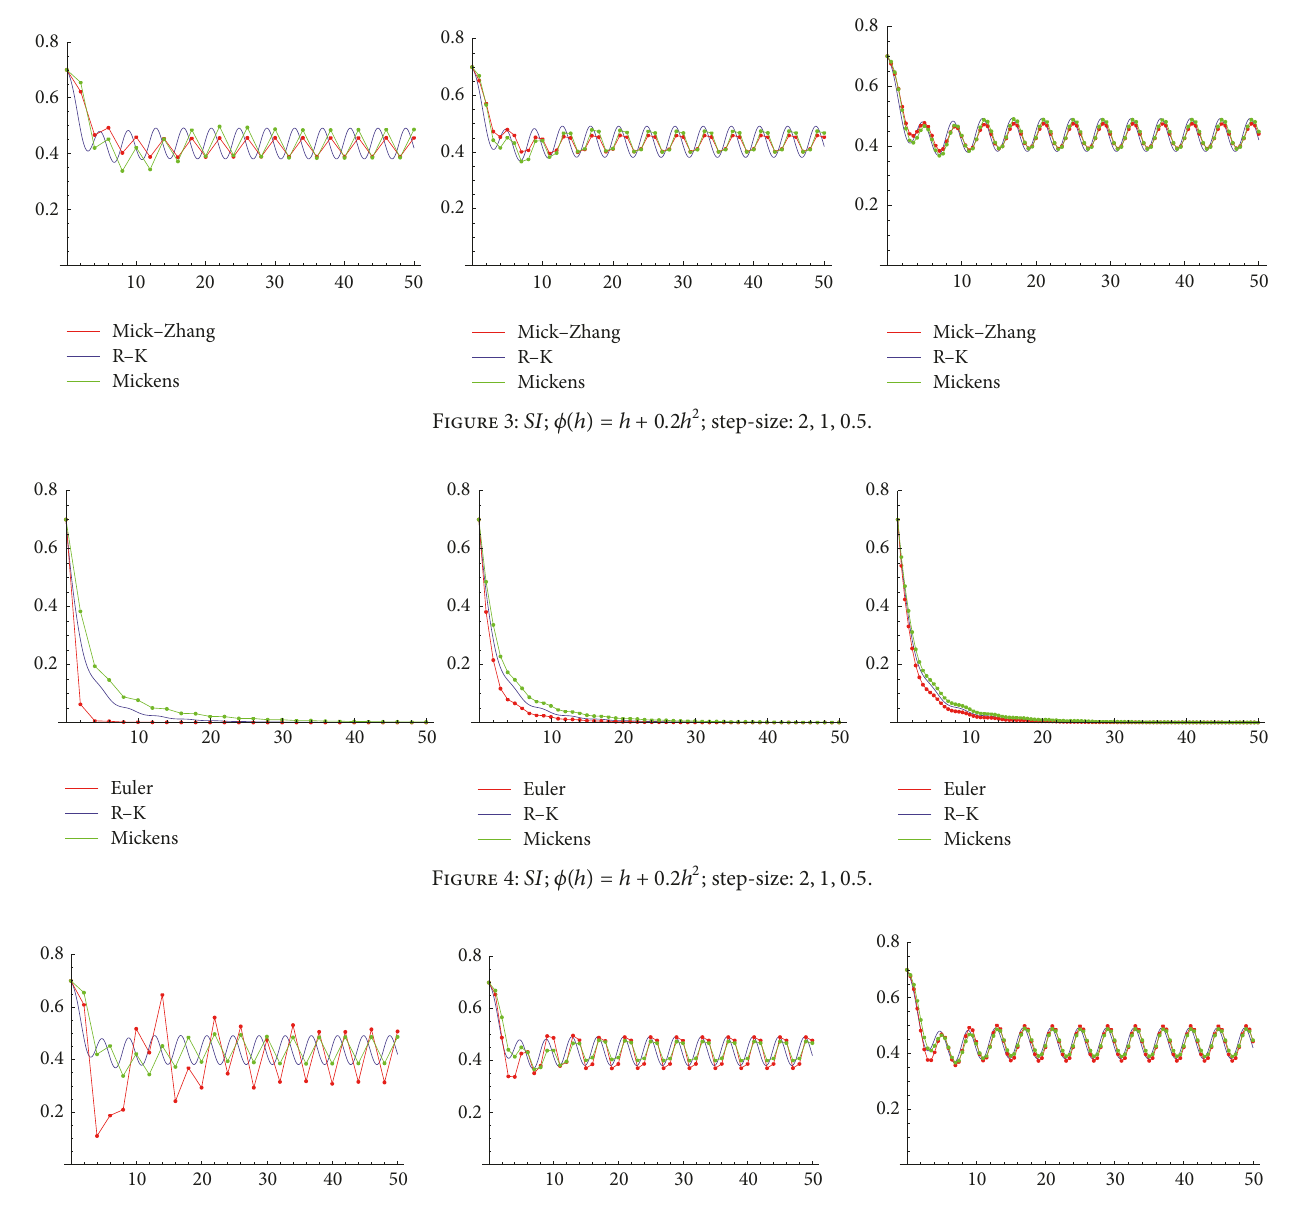
Figure 5: 𝑆𝐼 ; 𝜙(ℎ) = ℎ + 0.2ℎ 2 ; step-size: 2 , 1 , 0.5